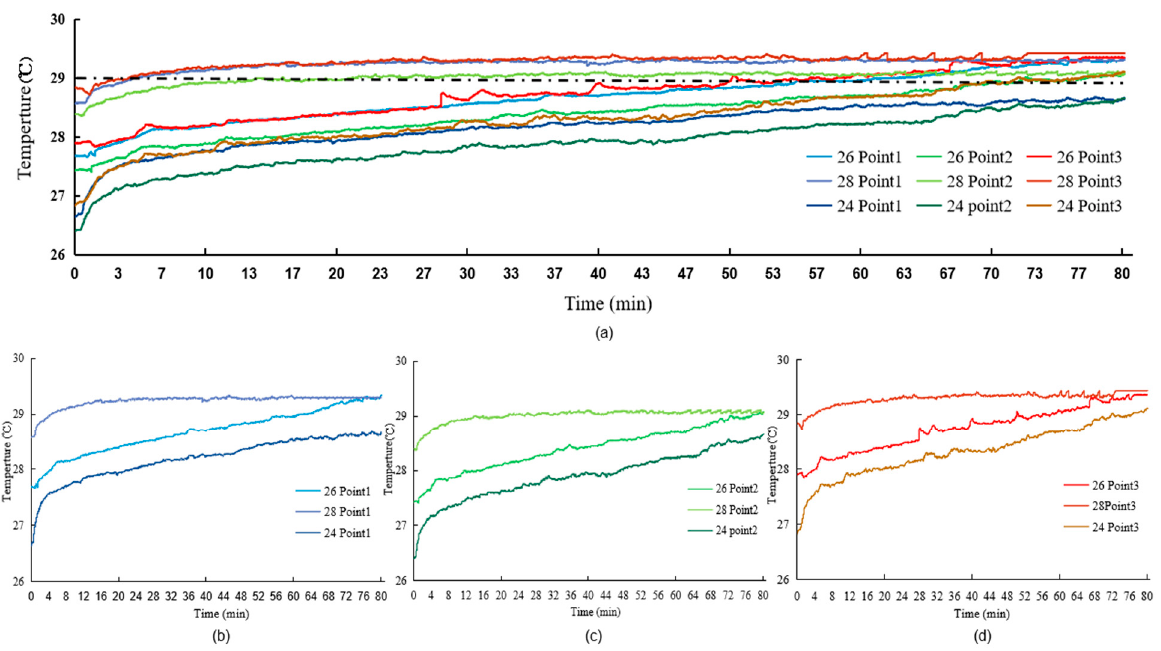
Figure 10. Temperature time series distributions at monitoring points with ventilation